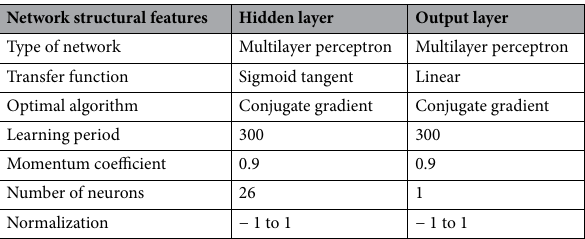
Table 2. The optimal structure of an artificial neural network for the forecast of NO 2 concentration.